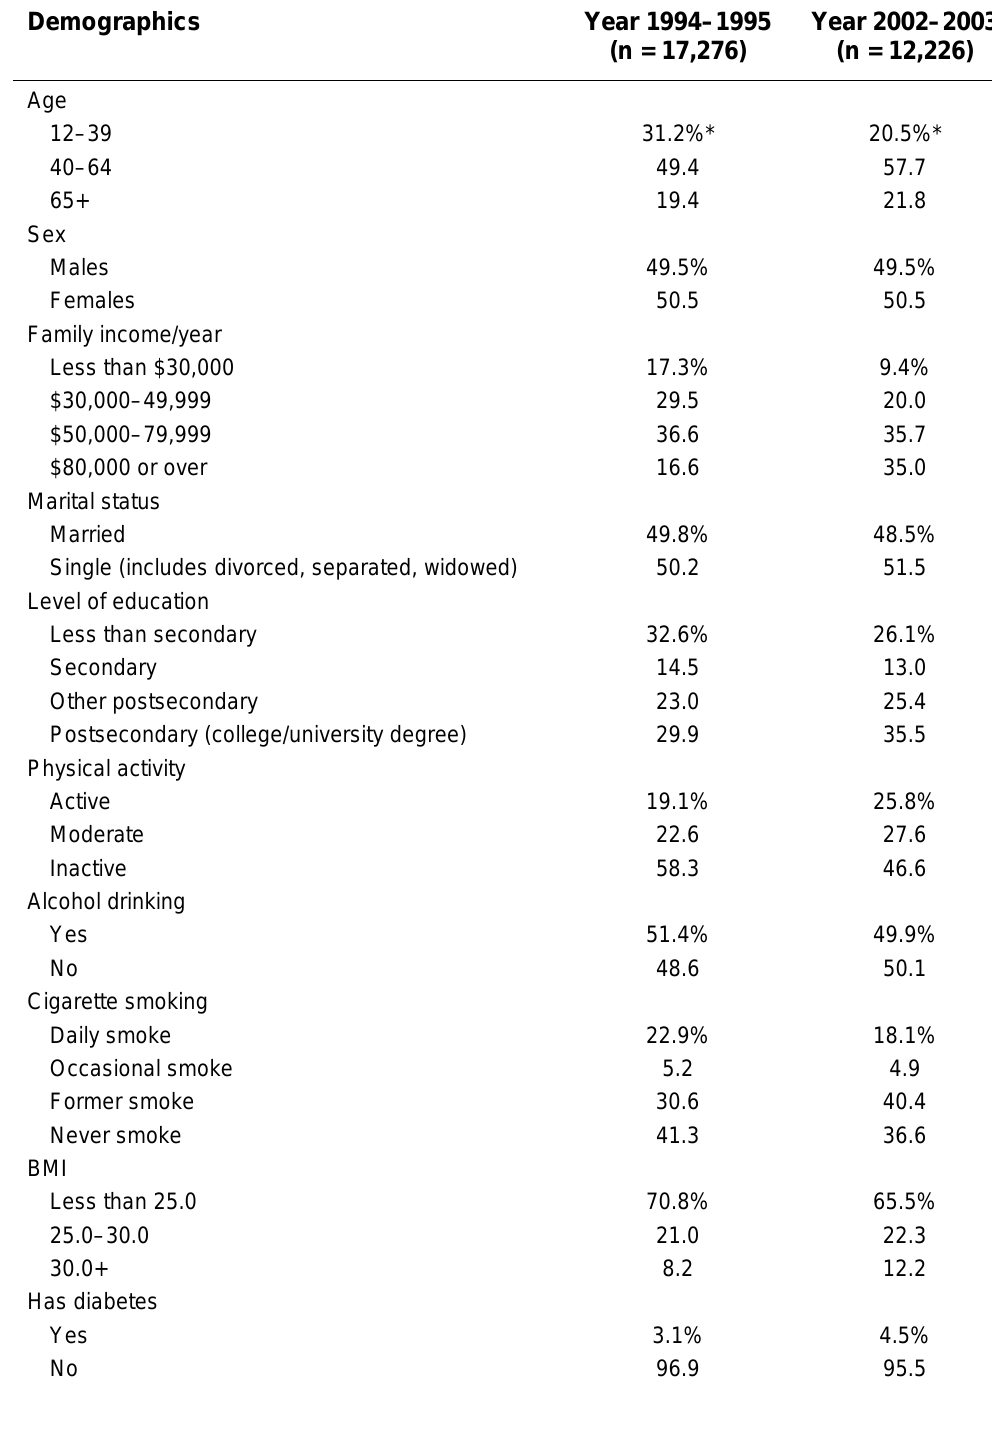
Demographic Characteristics of Sample, NPHS Longitudinal Data, from